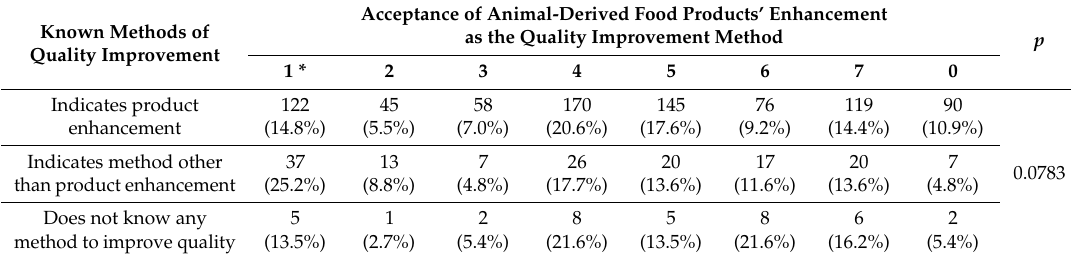
Table 4. Level of acceptance of enhanced animal-derived food products for respondents stratified by known methods of quality